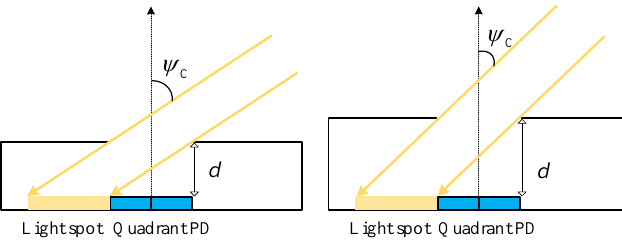
Figure 4. Relation between the FOV-C of the QADA receiver and the aperture